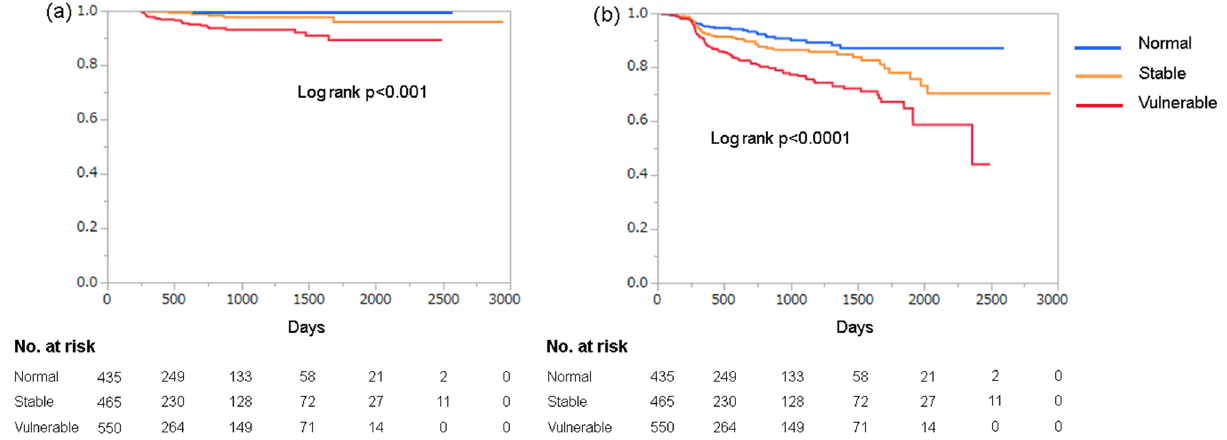
Figure 5. Clinical outcomes in patients with CAD diagnosed by the AI algorithm. Kaplan–Meier curves of the event-free survival from the OCT-observed segments ( a ) and the composite of the clinical events ( b ) according to classification by the AI algorithm. Patients with OCT-diagnosed vulnerable plaques showed higher cumulative rates for both endpoints than the patients with OCT-diagnosed normal and stable